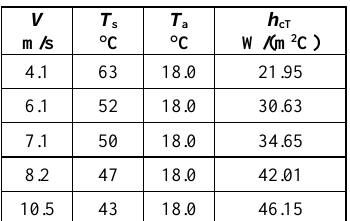
A NALYTICAL R ESULTS B ASED ON THE C OMBINATION OF E XTERNAL AND I NTERNAL F ORCED C ONVECTION